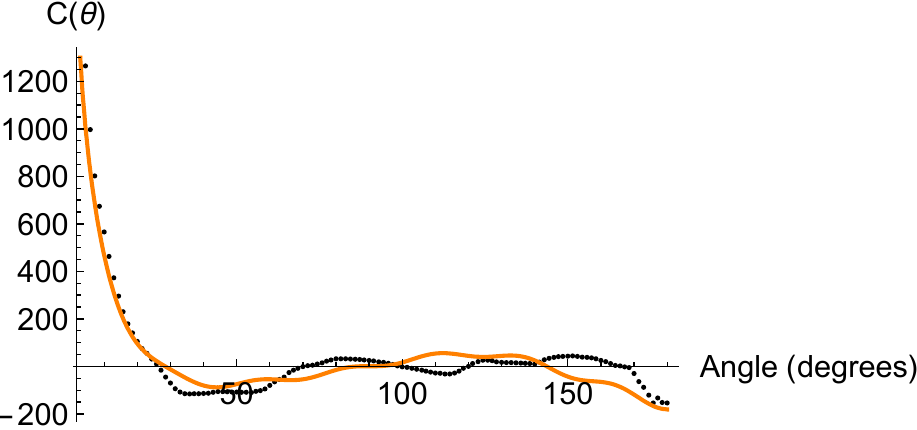
Figure 3. Two-point correlation function C ( θ ) (orange solid curve) obtained from the fit to Planck 2018 = 5.34 and u odd = u even data for u even /2 = 2.67. The fit is not so good as in Figure 1 (lower panel), min min min but the number of fitting parameters is smaller and, above all, provides a theoretical foundation that simultaneously explains the lack of large-angle correlations and the observed odd-parity dominance leading to a downward tail near 180 ◦